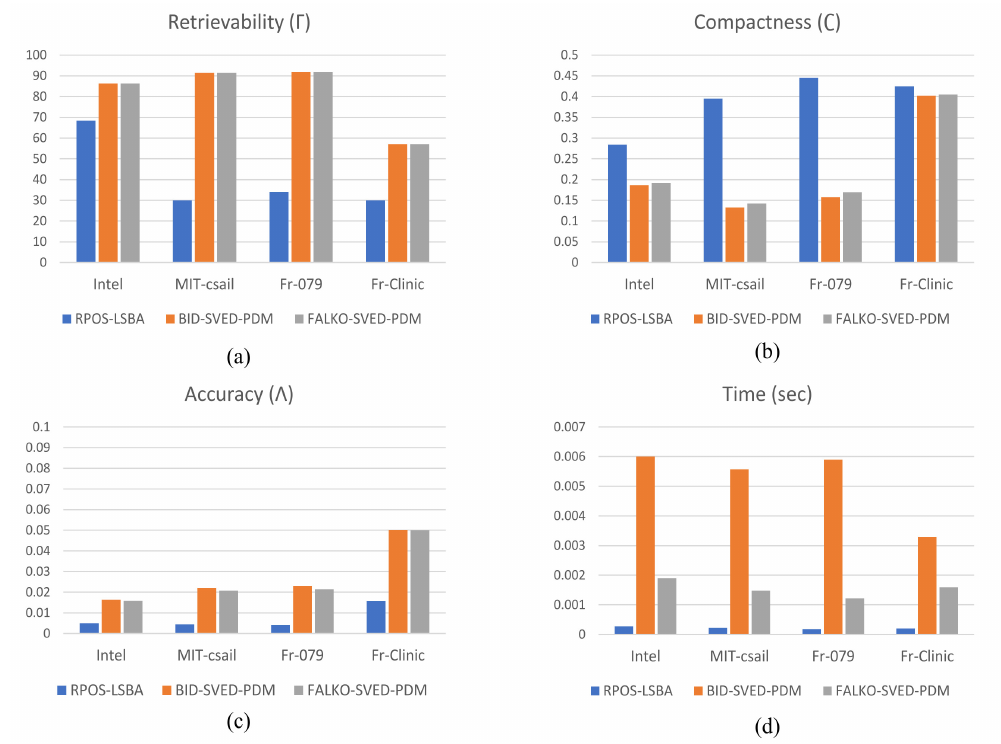
Figure 12. The retrievability ( a ), compactness ( b ), accuracy ( c ), and execution time ( d ) results of complete data sets for all three approaches using all three methods. The vertical axis shows the quantitative measure of the performance of all three methods, and the horizontal axis shows data set